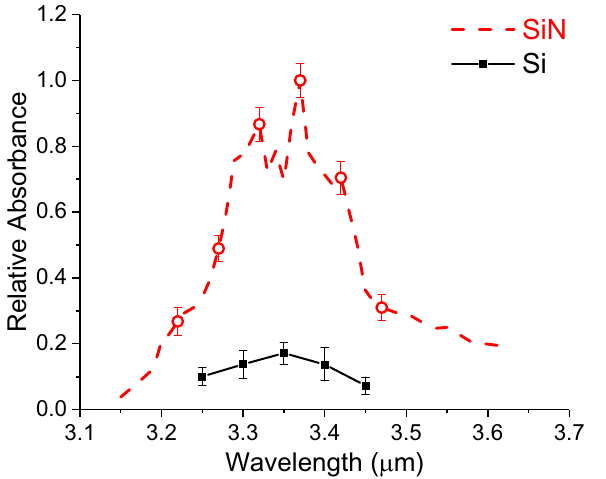
Figure 9. Measured results of acetone using SiN waveguides compared with Si waveguides. The waveguide width = 10 μm and thickness T = 1 μm.